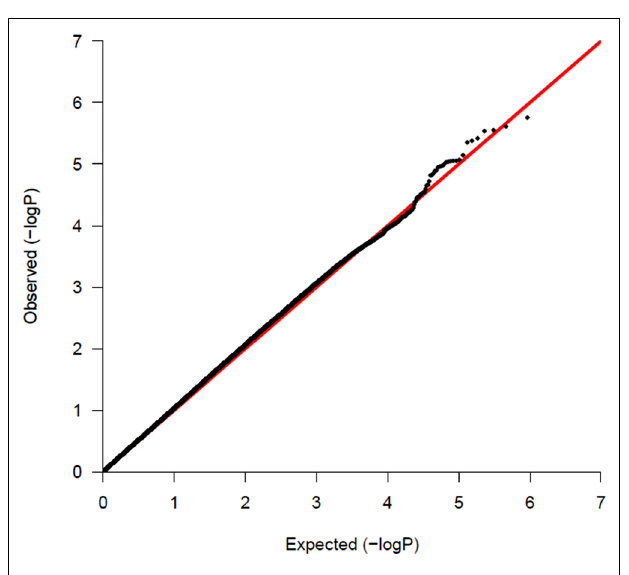
FIGURE 2 | QQ-plot of the p -values of common variant analysis